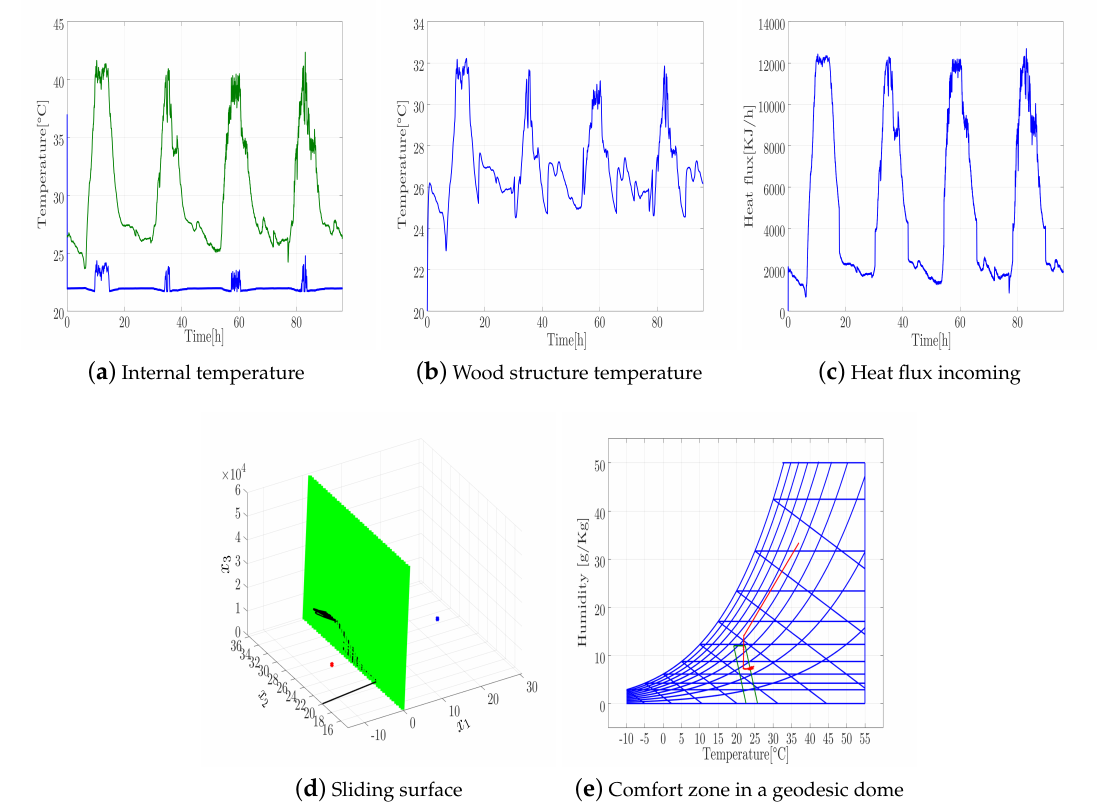
Figure 8. System variables with a 12,600 KJ cooling